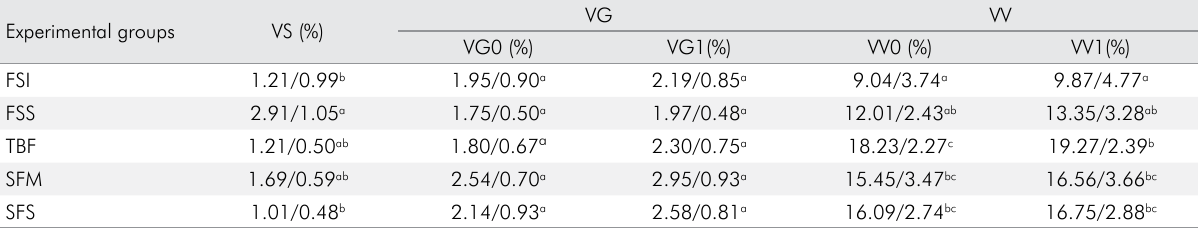
Table 2. Volume of polymerization shrinkage (VS), gap (VG), and void (VV) using µCT (mean/SD*). Experimental groups